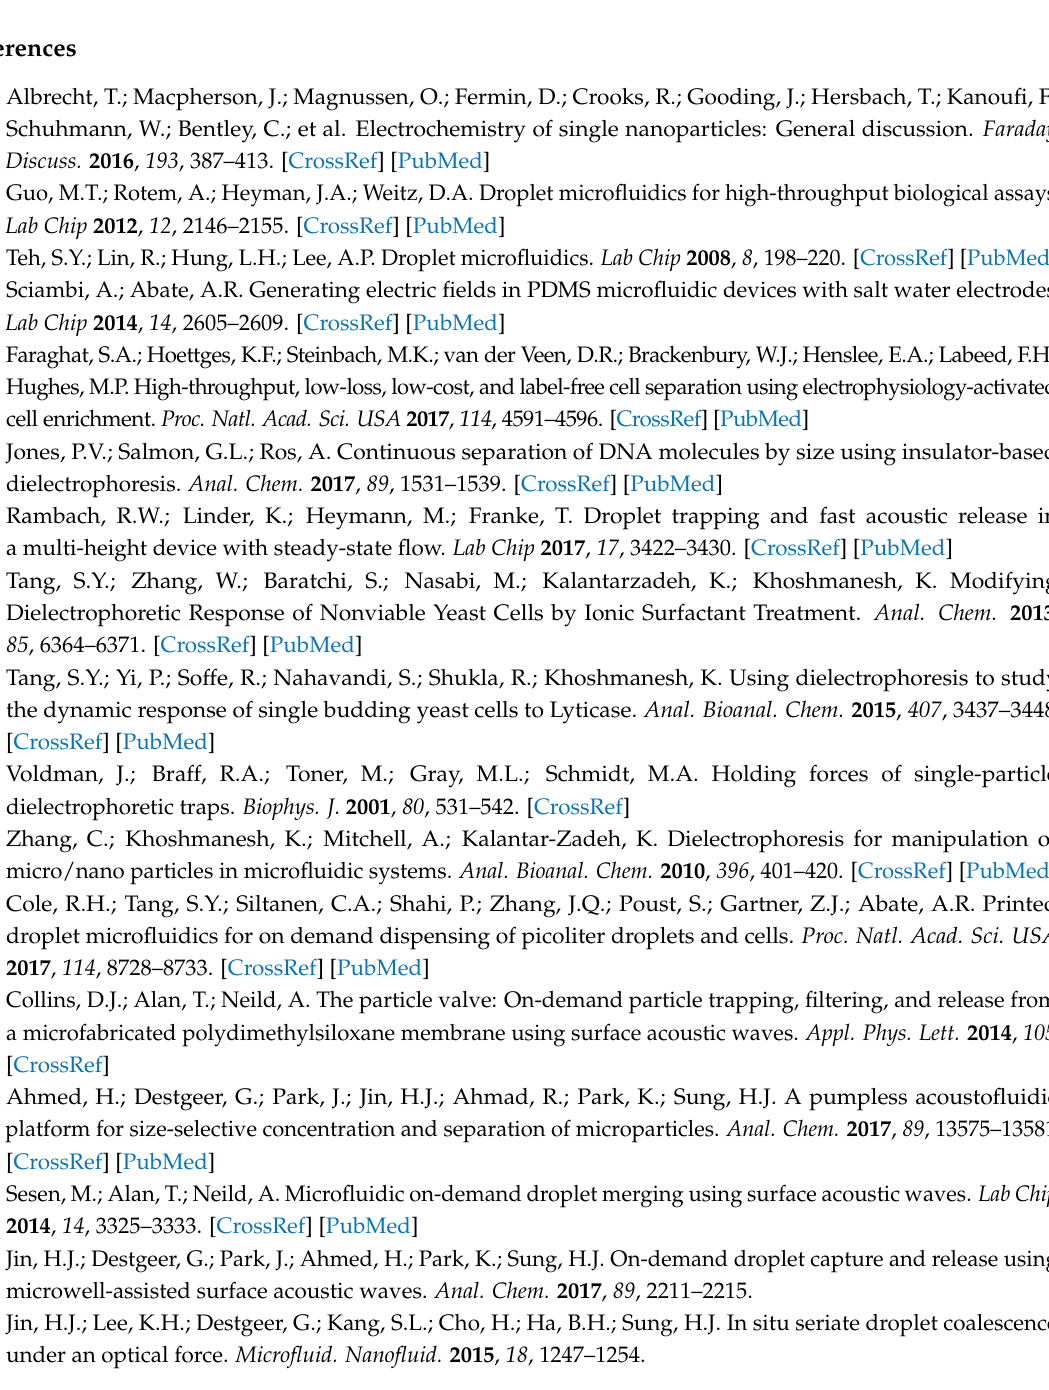
analysis of a single particle in the